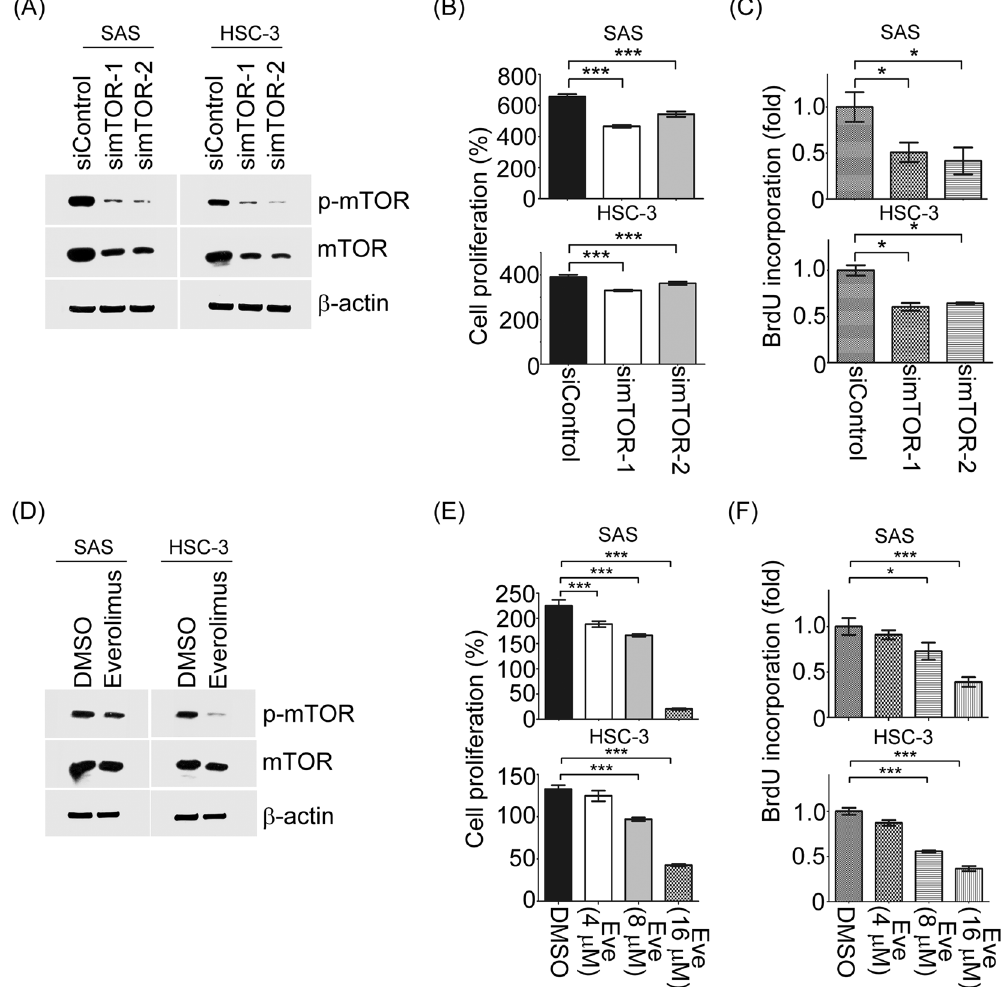
Figure 3. mTOR activity involved in cell proliferation of tongue cancer cells. ( A ) The protein expression levels of total mTOR, and phosphorylated mTOR were demonstrated in SAS and HSC-3 cells transfected with siControl and simTOR by Western blotting. ( B and C ) The cell growth abilities of siControl and simTOR in both SAS and HSC-3 cells were measured by MTT and BrdU assays. ( D ) The protein expression levels of total mTOR, and phosphorylated mTOR were detected in SAS and HSC-3 cells treated with everolimus or DMSO by Western blotting. ( E and F ) the cell growth abilities of both two cells treated with everolimus in a dose-dependent manner were assessed by MTT and BrdU assays. Eve: everolimus. * p < 0.05; ** p < 0.01, *** p <